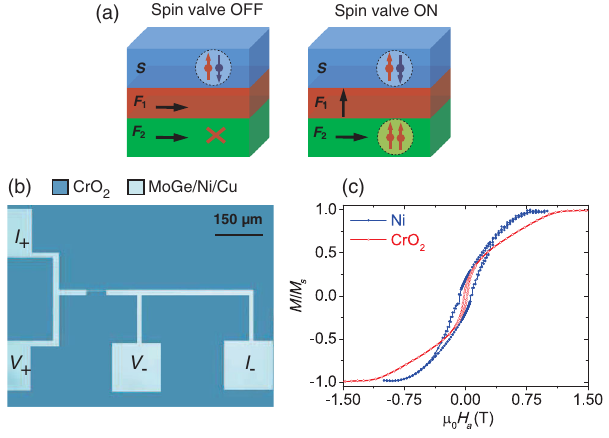
FIG. 1. Device structure and magnetic characterization. (a) Working principle of a triplet spin valve (TSV) with a half-metallic ferromagnet; the TSV is off (on) when the magne- tizations of F 1 and F 2 are collinear (noncollinear), with a maximum effect when they are orthogonal. (b) Optical micro- graph of a typical TSV where a MoGe ð d s Þ = Ni ð 1 . 5 nm Þ = Cu ð 5 nm Þ trilayer bridge of 10 μ m width is patterned on a 100 nm thin film of CrO 2 . (c) Magnetization hysteresis loops for CrO 2 ð 100 nm Þ and a multilayer ½ Ni ð 1 . 5 nm Þ = Cu ð 10 nm Þ(cid:2) 11 = Ni ð 3 nm Þ = Cu ð 10 nm Þ measured with the magnetic field perpendicular to the sample plane. The magnetization M is normalixed on the saturation magnetization M s , which is 2 . 2 × 10 5 A = m for the 6 . 8 × 10 5 A = m for the CrO 2 film and Cu = Ni